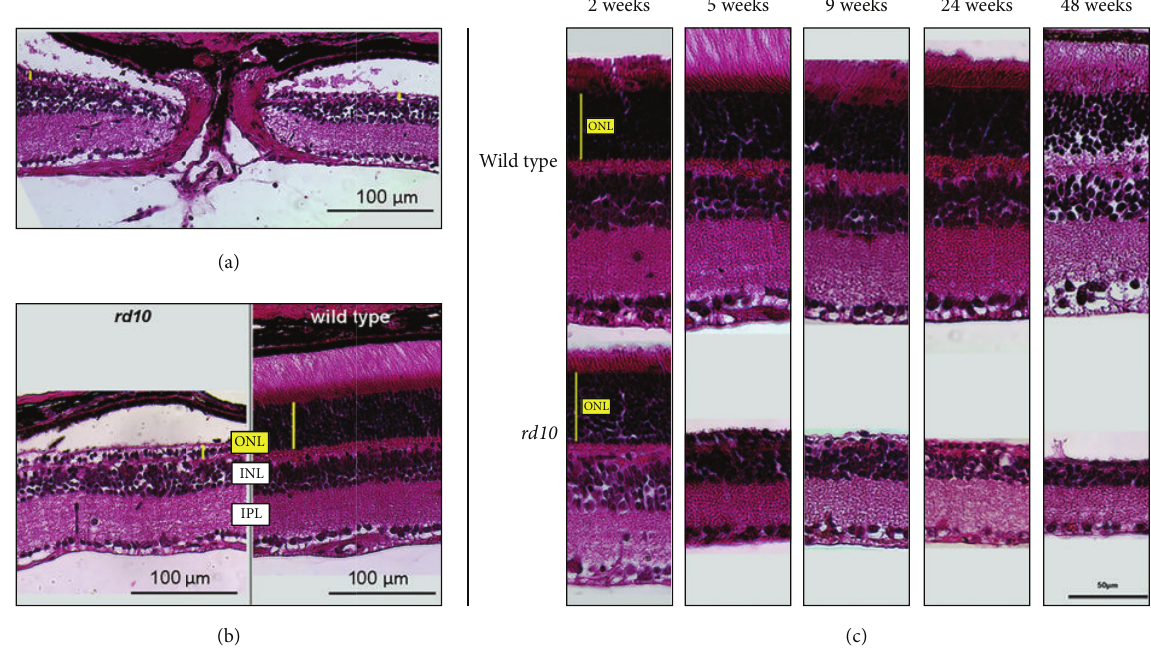
Figure 4: Histological evaluation of HE stained retinae. Pigment epithelium and photoreceptors are displayed to the top. (a) Area of evaluation. The papilla is cut directly through the median. (b) rd10 mouse retina at the age of five weeks (left) in contrast to wild type mouse (right). In rd10 mice, the ONL (yellow bars) was reduced to two layers of somata and the retina separated from the pigment epithelium. In wild type mice, outer segments of the photoreceptors were in contact with the pigment epithelium (same age; ONL = outer nuclear layer, INL = inner nuclear layer, and IPL = inner plexiform layer) (c) HE-staining of the retinae of wild type (first row) and rd10 mice (second row) at the age of 2, 5, 9, 24, and 48 weeks. In rd10 mice, the retinal thickness decreased with age, whereas in wild type mice, no differences in thickness were